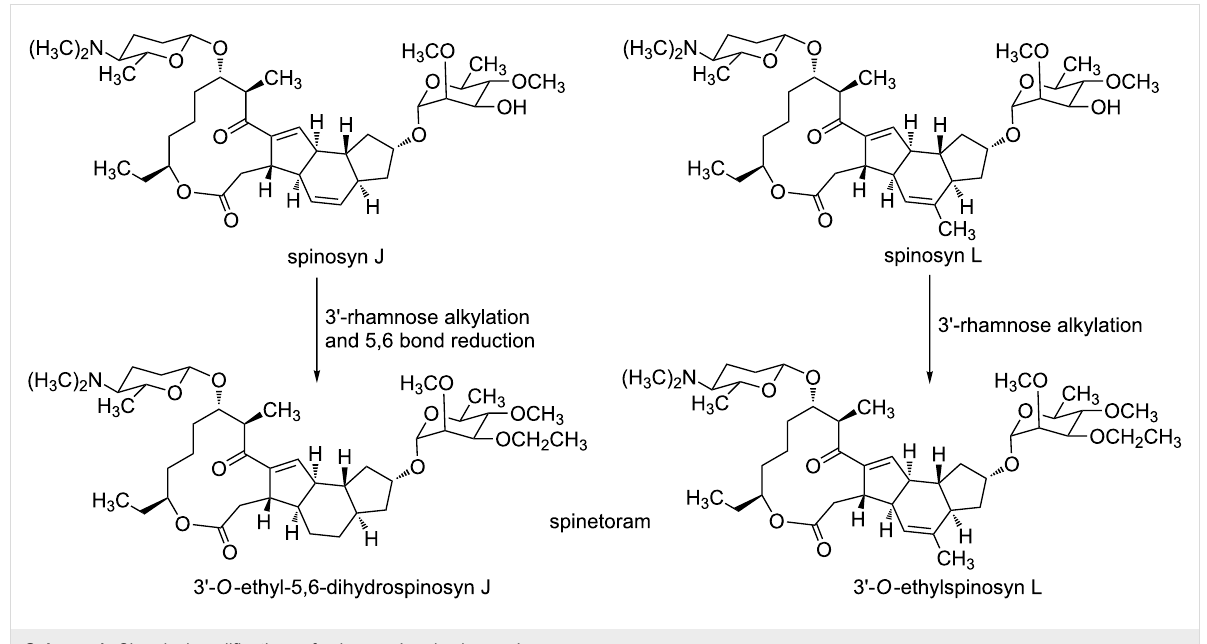
Scheme 1: Chemical modifications of spinosyn J and spinosyn L.